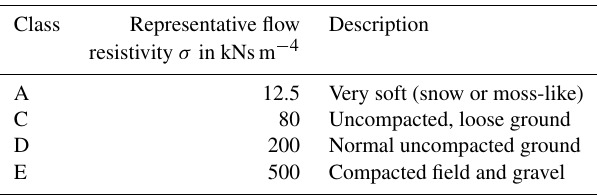
Table 5. Classification of selected ground impedance types, i.e. val- ues of flow resistivity according to Plovsing and Kragh